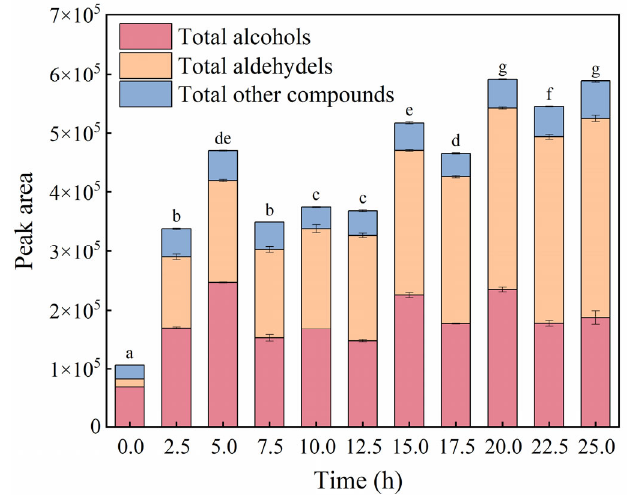
Figure 2. Change in the total peak area of aldehyde, alcohol, and other compounds identified in oil samples with different heating times. Different superscript letters indicate significant differences in the total peak area of all volatile compounds ( p <